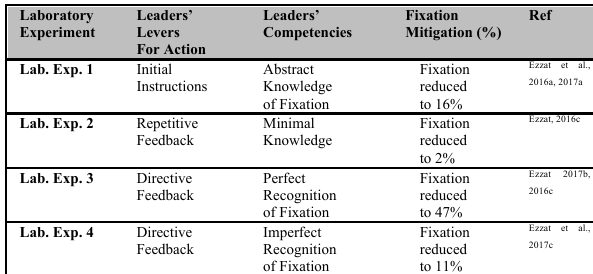
Table 2. Lab experiments for leadership-based defixation